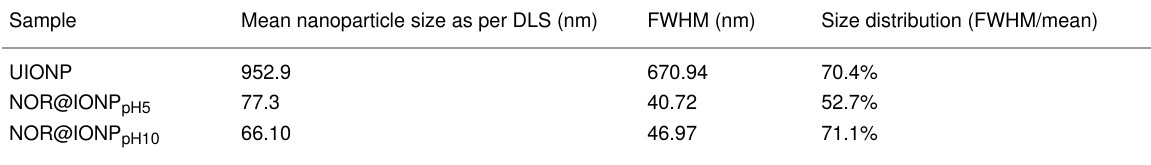
Table 1: Hydrodynamic diameter, the FWHM and size distribution of respective UIONP, NOR@IONP pH5 and NOR@IONP pH10 samples. Sample